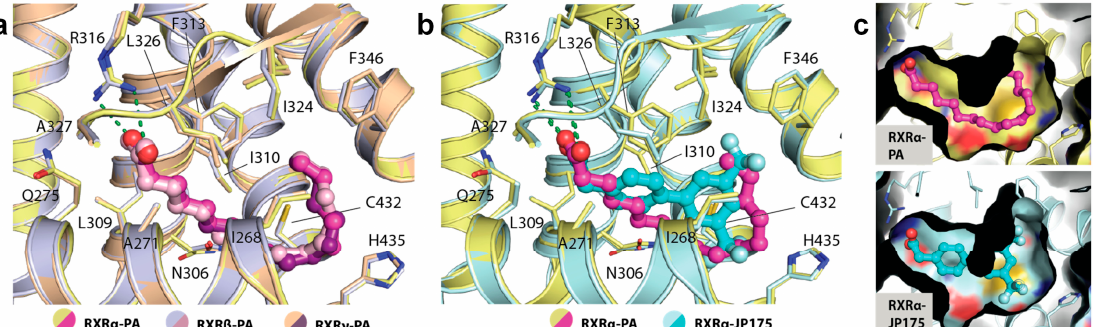
Figure 3. The binding mode of palmitic acid in RXRs. ( a ) Detailed interactions between PA and three RXR isoforms demonstrate high conservation of the binding mode of the fatty acid. Numbering is based on RXR α . ( b ) Structural comparison reveals PA occupying a similar space as typically exploited by other synthetic small molecule modulators. ( c ) Surface representation comparing the binding modes of PA and JP175 [31] suggests that highly flexible PA with L-shape conformation potentially utilizes a space-filling mechanism for its binding to RXRs.